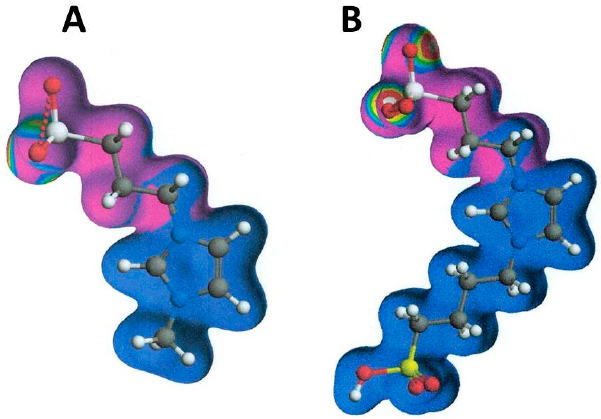
Figure 4. Imidazolium ligands: ( A ) imidazolium ligand [62] and ( B ) imidazoium zwitter ion ligand [63]. For an explanation of the color used see Figure 2.